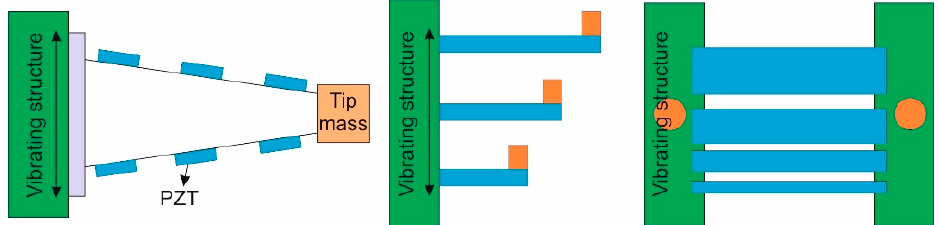
Figure 6. Finger-like systems of elastic beams with an extended spectrum of resonance frequencies using the piezoelectric effect (PZT-Lead Zirconate Titanate piezoelectric materials).